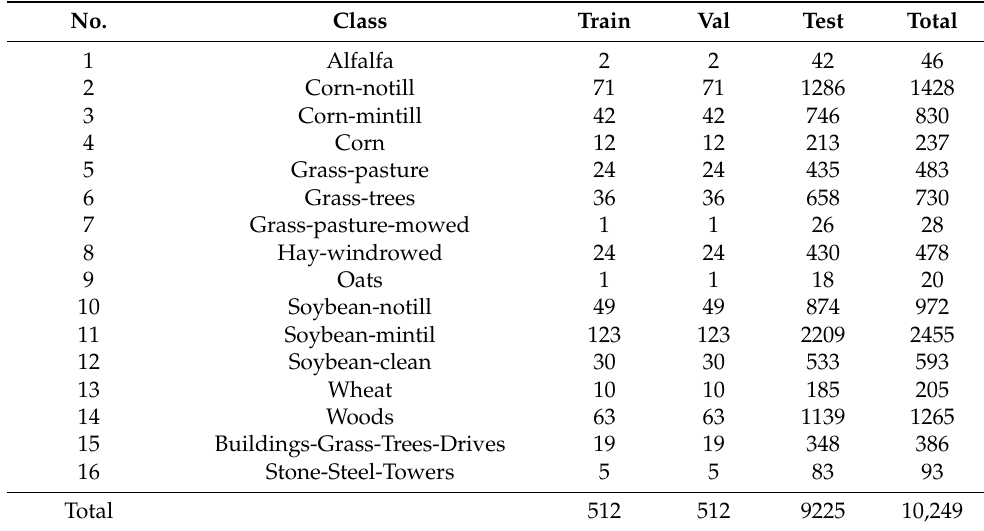
Table 5. Land-cover classes and corresponding numbers of samples in the IP dataset.